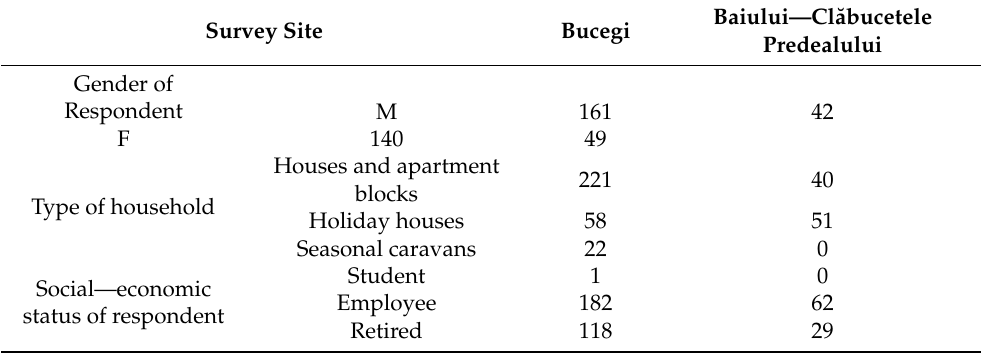
Table A3. Characteristics of the respondents.